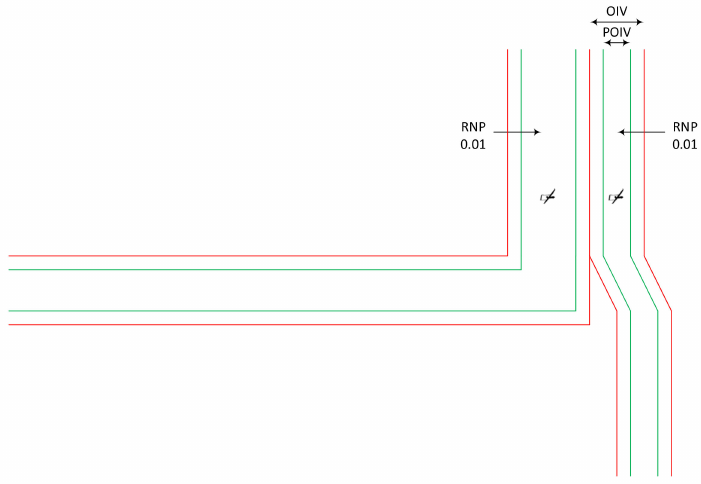
Figure 10. Deconflicted OIV. Adapted from [77].